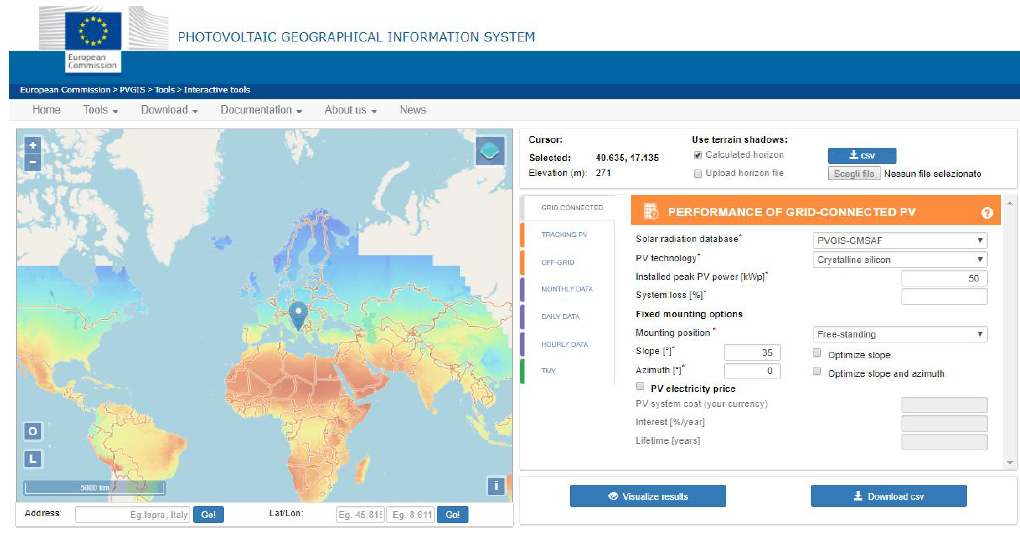
Figure 1. Photovoltaic Geographical Information System (PVGIS).